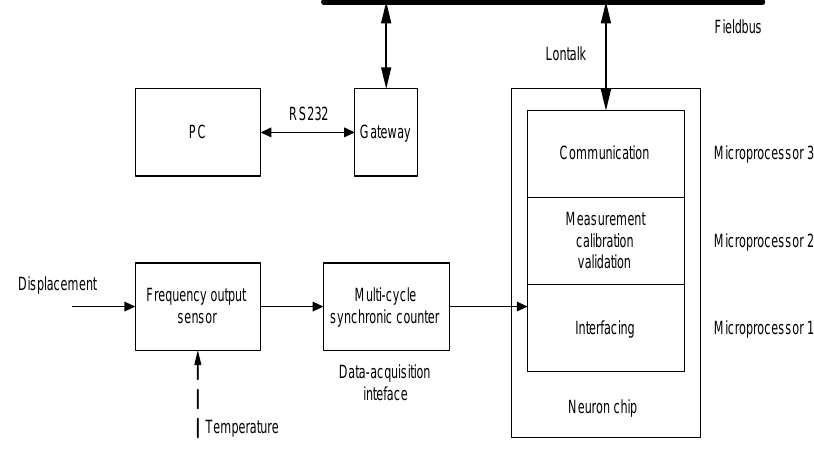
Figure 6. A fieldbus-based intelligent frequency output sensor